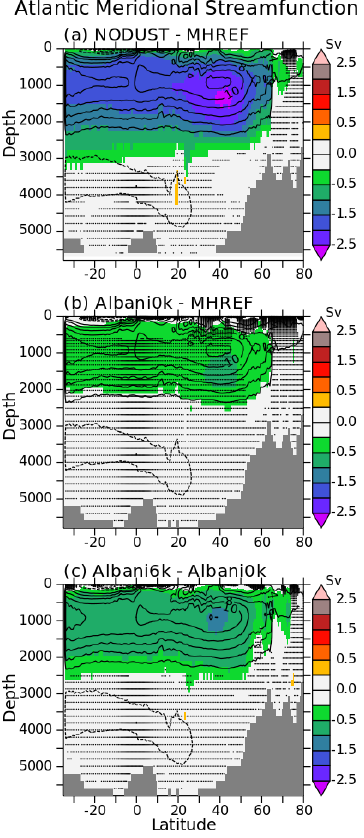
Figure 14. Differences in the meridional Atlantic overturning cir- culation (Sv) as a function of latitude ( ◦ ) and depth (m) showing the effect of (a) NODUST, (b) Albani0k dust and (c) Albani6k dust on the mid-Holocene simulations. For (a) and (b) the reference is the reference mid-Holocene simulation MHREF, whereas for (c) the reference is the Albani0K mid-Holocene simulation. Stippling indicates values that are smaller than the centennial variability mid- Holocene estimate from MHREF. The test is done at each grid point, which is also a way to show the ocean model resolution with refined grid at the Equator and higher resolution at the ocean